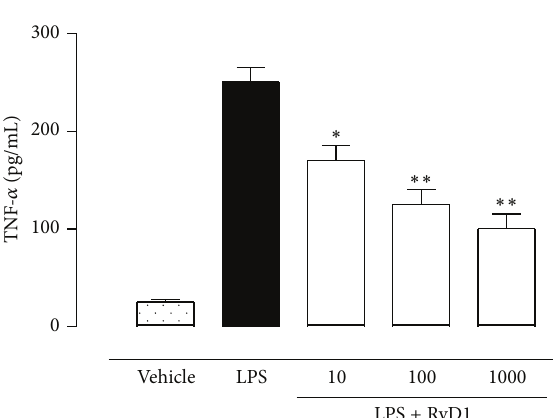
Figure 5: Resolvin D1 (RvD1) and TNF-alpha. ELISA for TNF-alpha (TNF- 𝛼 ) in ocular tissues of vehicle, LPS, and LPS+RvD1 (10-100- 1000 ng/kg) treated rats as reported in materials and methods. Values are mean ± SEM of 𝑛 = 6 observation for each group. ∗ 𝑃 < 0.05 and ∗∗ 𝑃 < 0.01 versus LPS treated rats.